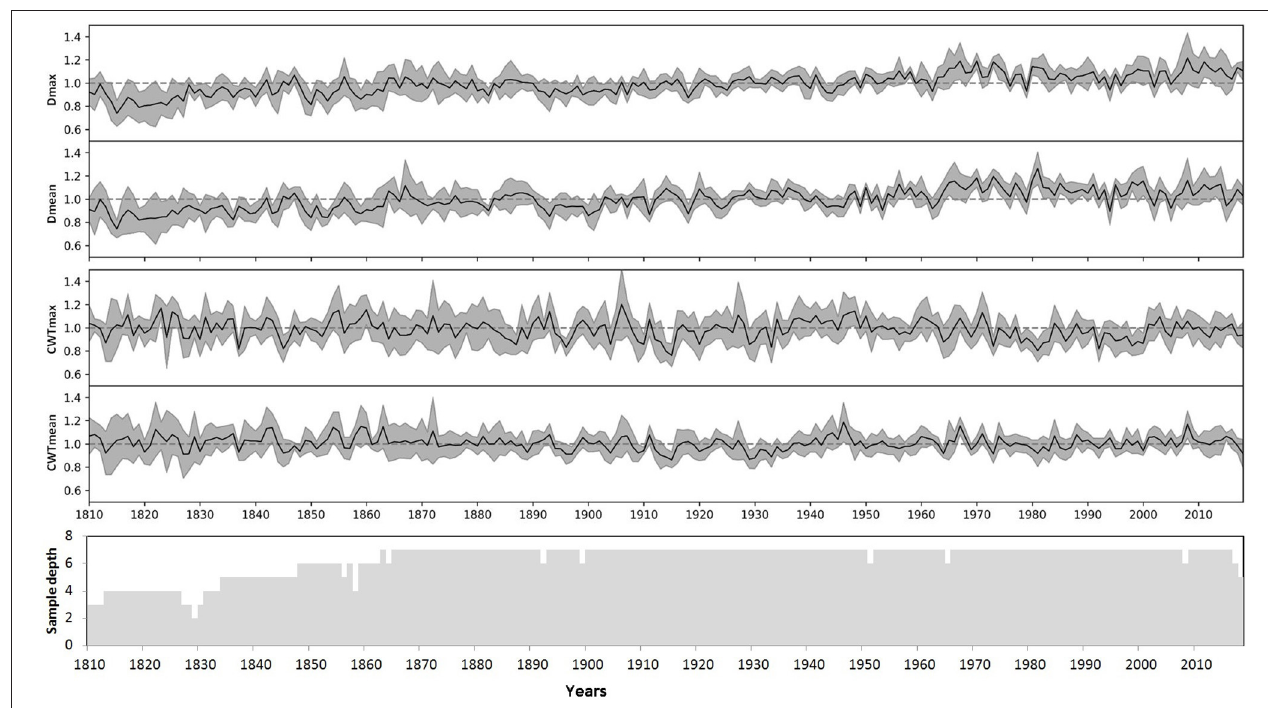
FIGURE 5 | Local indexed chronologies of anatomical characteristics of the Scots pine: maximum ( D max ) and mean ( D mean ) values of cell radial diameter, maximum ( CWT max ) and mean ( CWT mean ) values of cell wall thickness in the tree ring. Lines represent local average chronologies; shaded areas represent standard deviations for each calendar year. The bottom panel shows the dynamics of the sample depth (number of individual series), taking into account missing and discarded